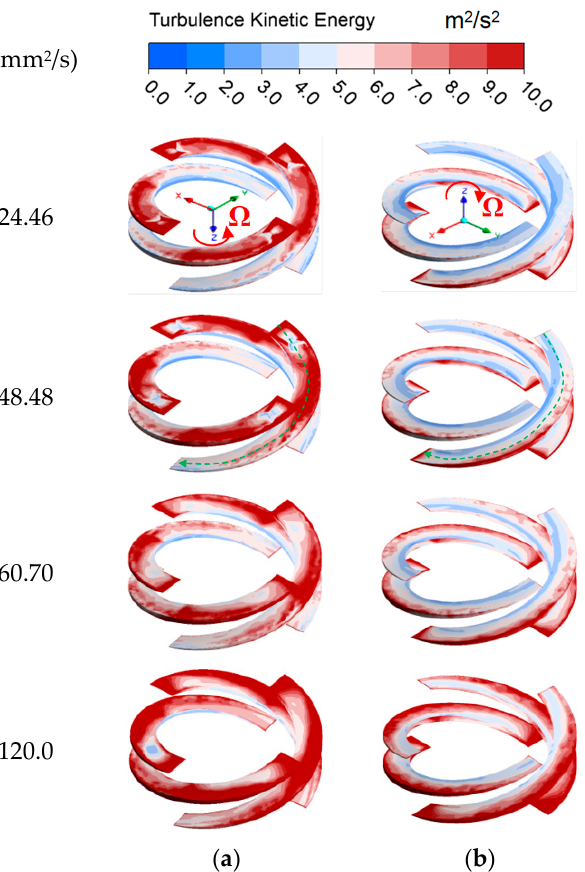
Figure 11. Distribution of turbulent kinetic energy on blade: ( a ) suction surface (SS) and ( b ) pressure surface (PS) ( Δ = 3%, the green dash lines represents the streamline at 0.5 times blade height).